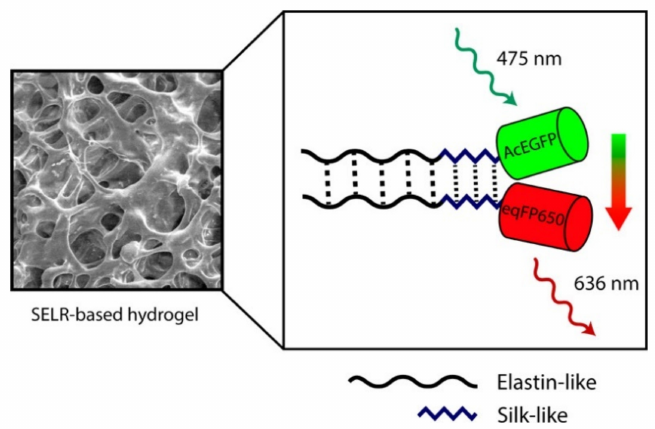
Figure 3. Silk/elastin-like recombinants (SELR) with fluorescent proteins hydrogel formed by silk/elastin-based network, linking two different fluorescent proteins which undergo FRET when they target biomolecules. Reprinted with permission from reference [85]. Copyright 2017 American Chemical